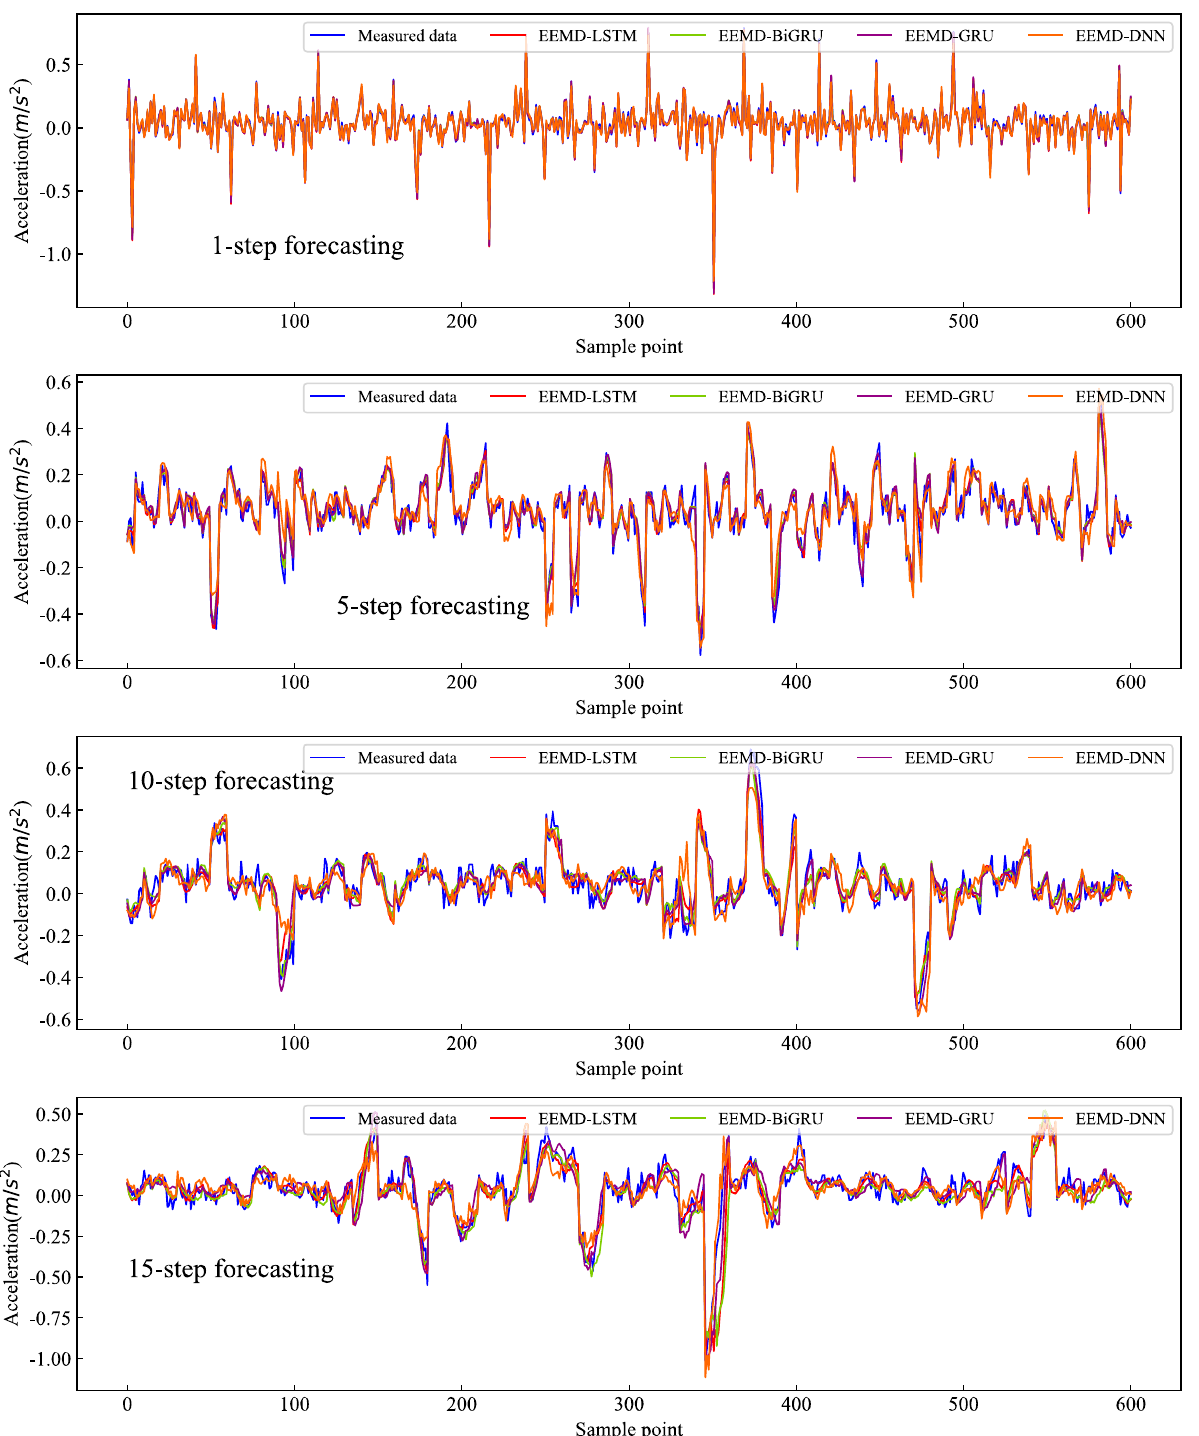
Figure A1. Comparisons results for the El-Centro dataset using the EEMD-based algorithms (from top to bottom, the order is 1-step forecasting, 5-step forecasting, 10-step forecasting, and 15-step forecasting).